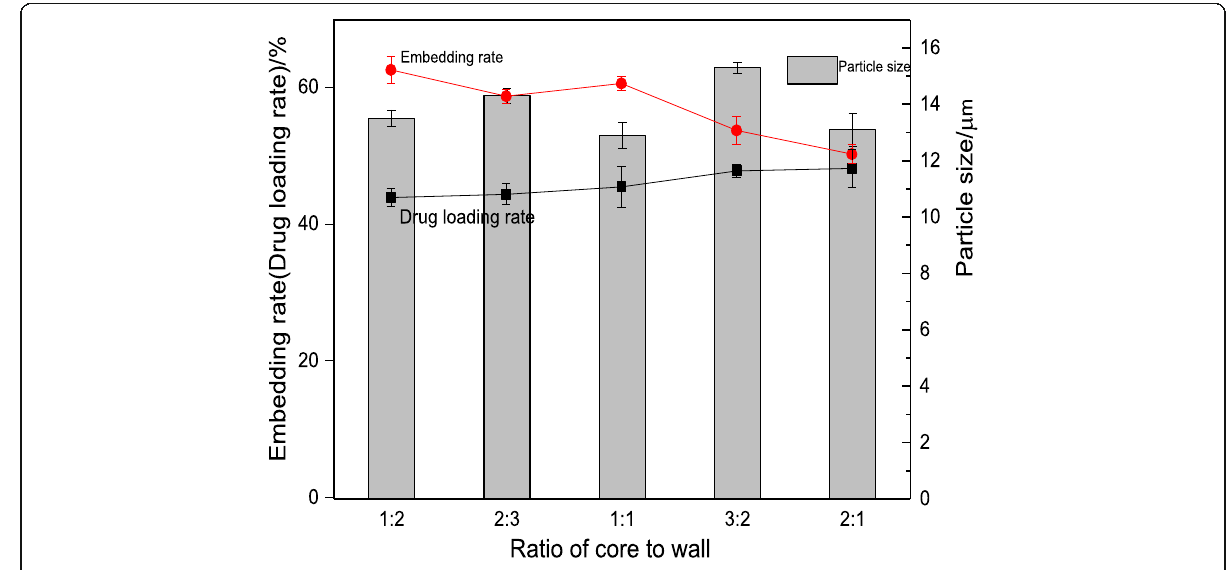
Fig. 8 Effect of core-to-wall ratio on microcapsule